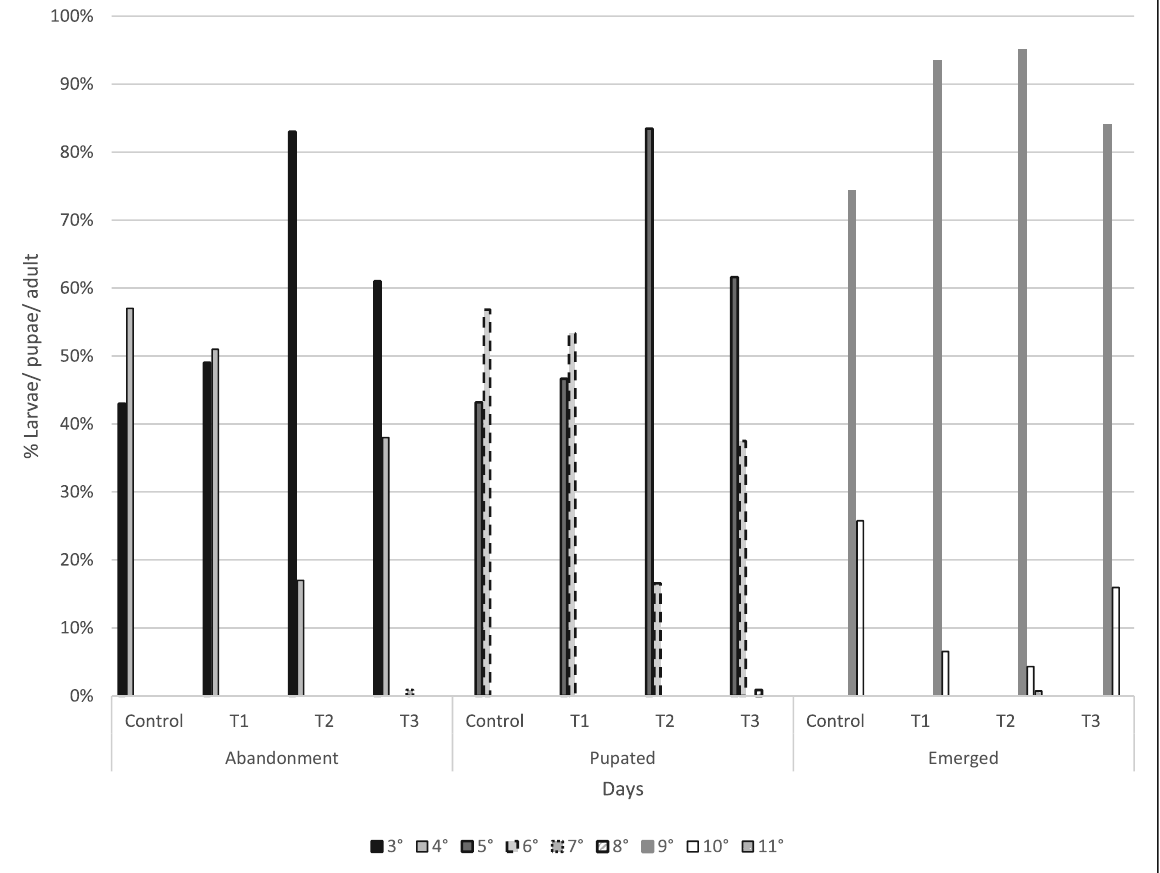
Figure 1 – Rate of diet abandonment, pupation and emergence (%) of Chrysomya putoria (Wiedemann, 1830) subjected to four treatments: control = gizzard homogenate agar; T1 = gizzard homogenate agar + ampicillin 41.66 μ g/mL, T2 = gizzard homogenate agar + ampicillin 81.33 μ g/mL, T3 = gizzard homogenate agar + ampicillin 166.66 μ